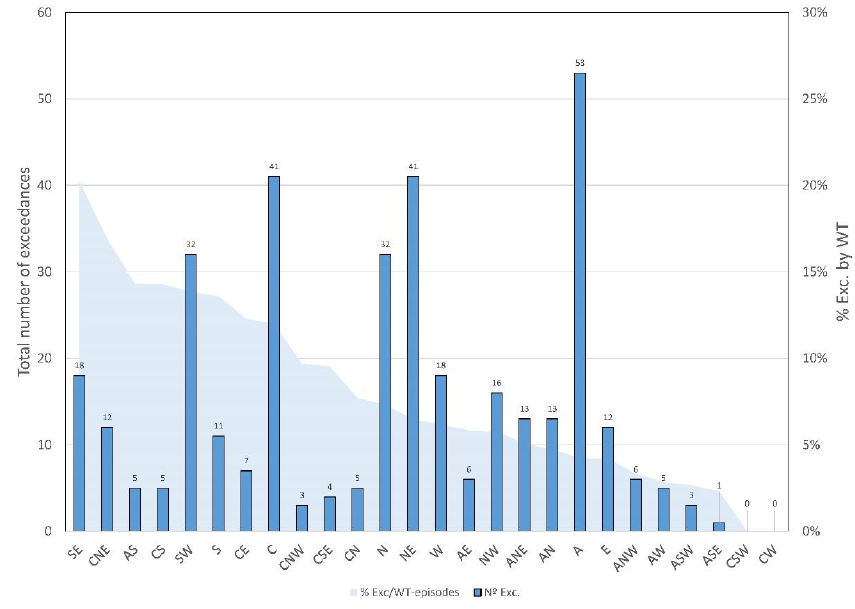
Figure 8. Total number of exceedances (PM 10 > 50 µg m − 3 ) for each weather type in the period 2005–2019, and ratio (in percentage) between the number of exceedances and the total number of episodes for each weather type.